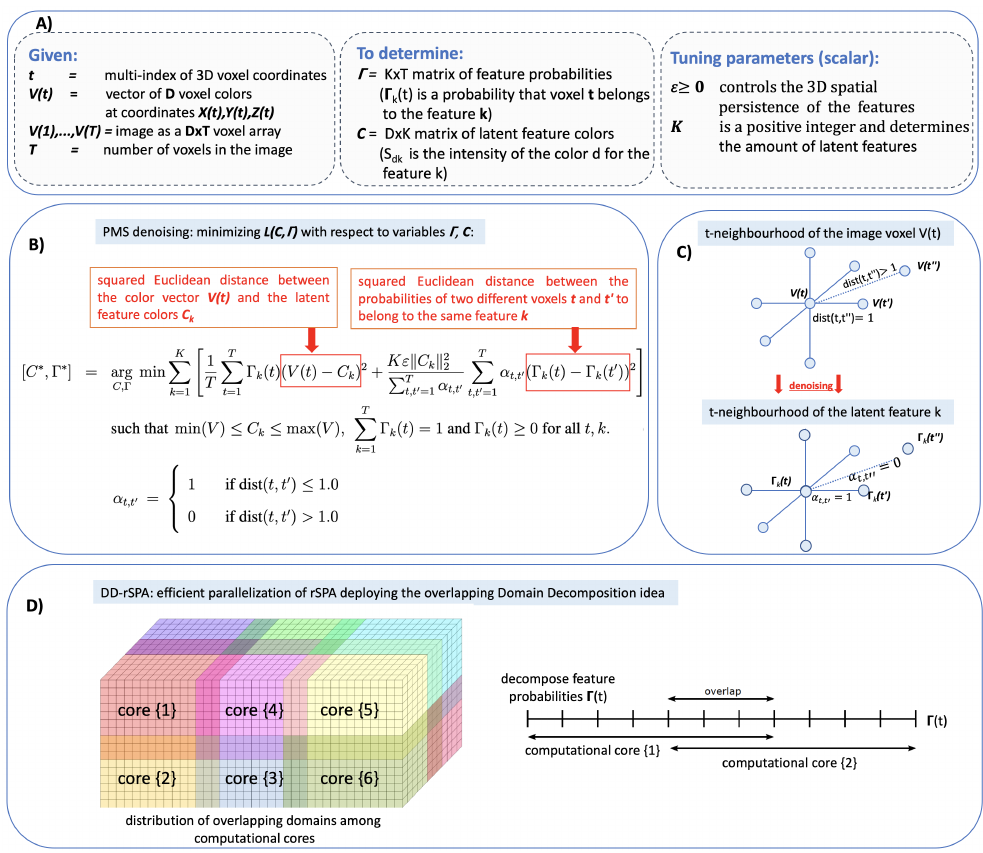
Figure 2. Graphical overview of the Probabilistic Mumford–Shah (PMS) framework. ( A ) Summary of the parameters and variables. ( B ) Core rSPA algorithm idea: 3D-denoising with the regularized Scalable Probabilistic Approximation algorithm (rSPA). Given the (noisy) CT voxel data V , rSPA minimizes the function L ( C , Γ ) and seeks for the optimal segmentation of V in terms of the K spatially-persistent latent features characterized by the latent feature probabilities in K rows of the matrix Γ , as well as by the latent colors as K columns of the latent color matrix C . Persistency of the feature segmentation is imposed by the second term of the right-hand side of the function L ( C , Γ ) , which penalizes the differences in feature probability values in the spatially-neighboring points. ( C ) Denoising idea: latent feature probabilities are persistent (slowly-changing) 3D functions. ( D ) Graphical representation of the overlapping domain decomposition used in the parallel DD- rSPA